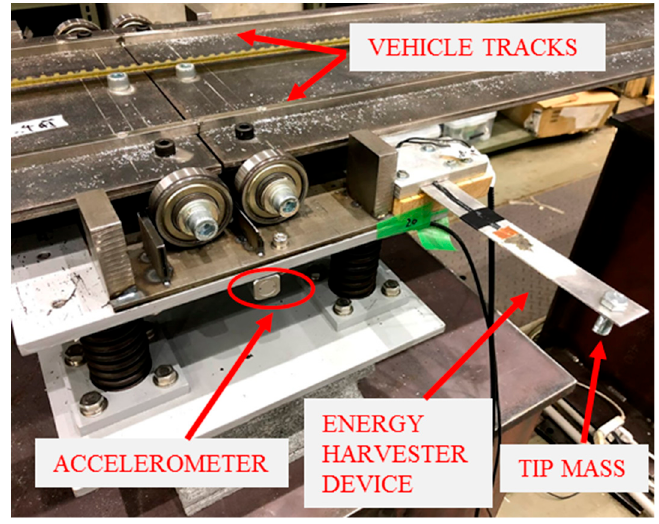
Figure 8. EHD installed on bridge pier.